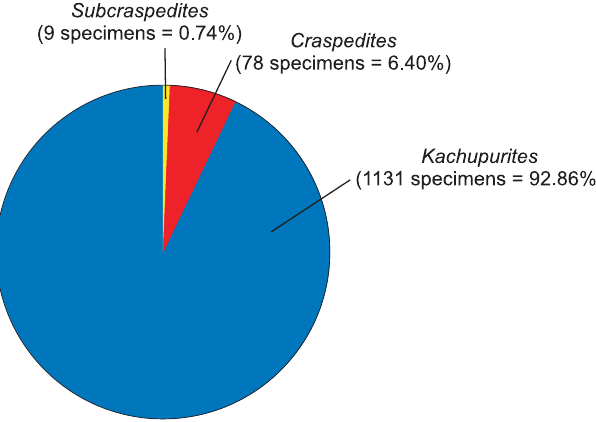
Fig. 4. The circular diagram of the frequency of the genera distribution in Kachpurites fulgens